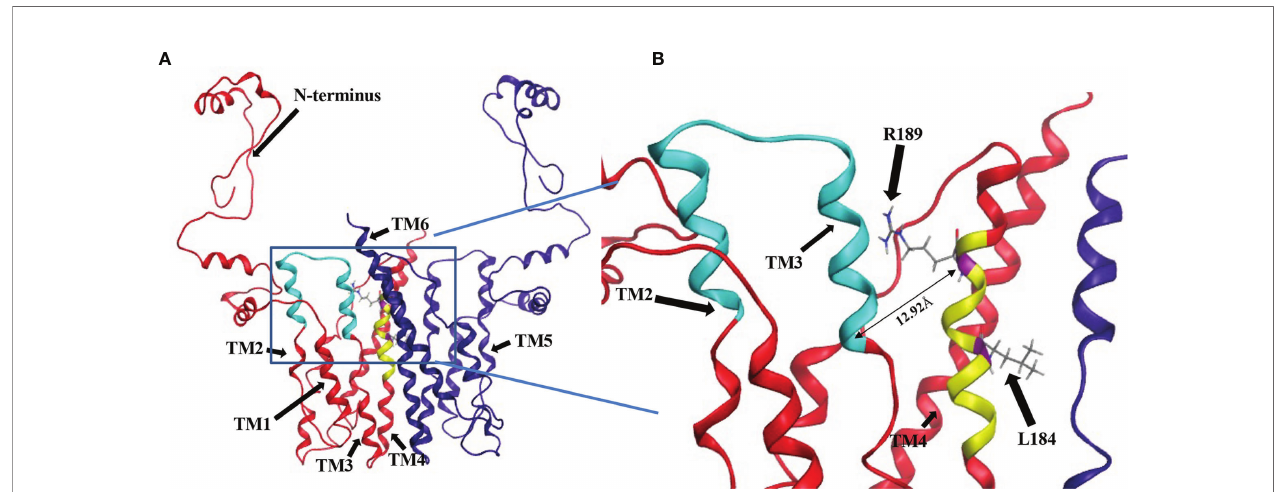
FIGURE 9 | Location of CDP-DAG and putative serine binding residues on a predicted structure of Cho1 based on homology modeling. (A) The homology model for the Cho1 protein was built based on the structure of the phosphatidylinositolphosphate (PIP) synthase from Renibacterium salmoninarum (PDB: 5D92) using Molecular Operating Environment 2019 software. The two Cho1 monomers are shown in red and dark blue, respectively. The CAPT motif is shown in cyan and the predicted serine binding motif is shown in yellow in the red monomer. TM1, TM2, TM3 and TM4 are indicated in the red monomer, while TM5 and TM6 are indicated in the blue monomer. (B) A zoomed-in image of the predicted active site of Cho1 and the locations of residues R189 and L184 on the red monomer is shown. The distance between C a atoms of residues R189 and D150 is measured at 12.92Å using Molecular Operating Environment (MOE) 2019